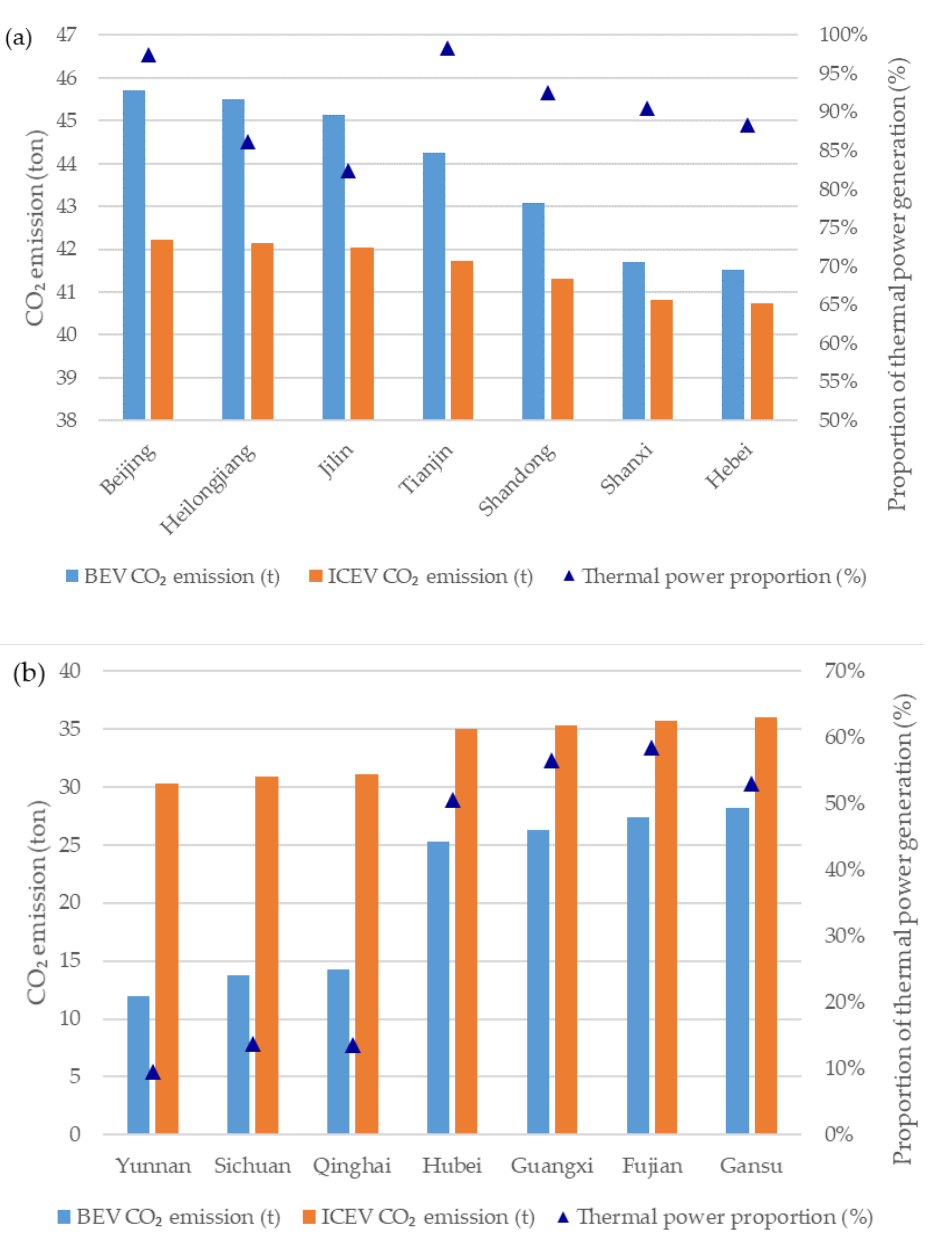
Figure 5. CO 2 emissions from BEVs and ICEVs and the proportion of thermal power in 14 selected regions. ( a ) seven regions with a high proportion of thermal power. ( b ) seven regions with a low proportion of thermal power.